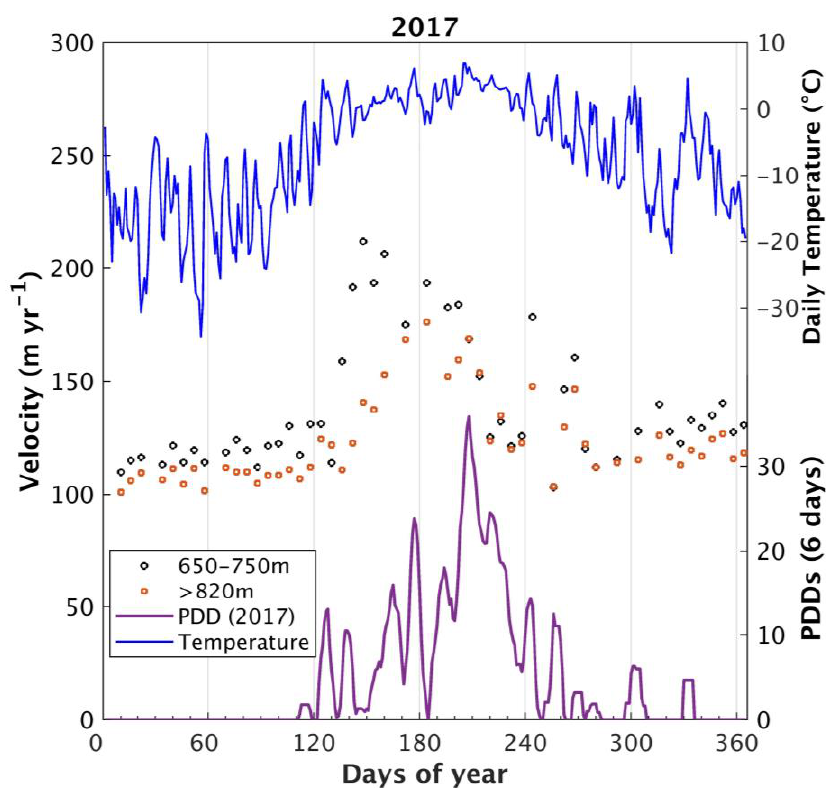
Figure 6. Averaged speed of three glaciers (G1, IG, and RG) with similar geometry and data sampling at two elevations bands during 2017. Also shown are daily temperature and positive degree days (PDDs) recorded at the nearby KAN_L automatic weather station (670 m.a.s.l.) and distributed by the Programme for Monitoring of the Greenland Ice Sheet.